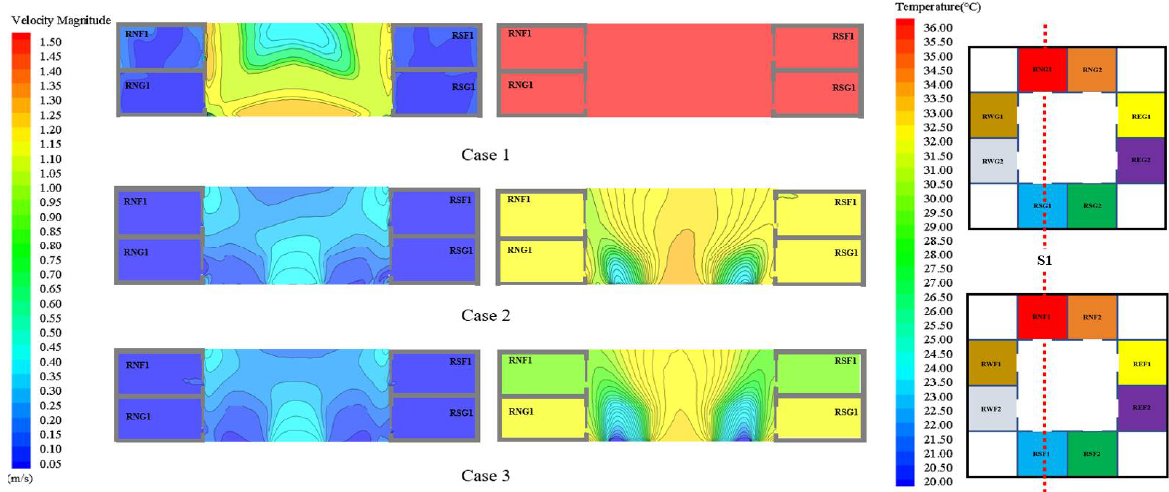
Figure 30. Contours for the wind speed magnitude and temperature within the courtyard with small and large trees (S1: X = 7500